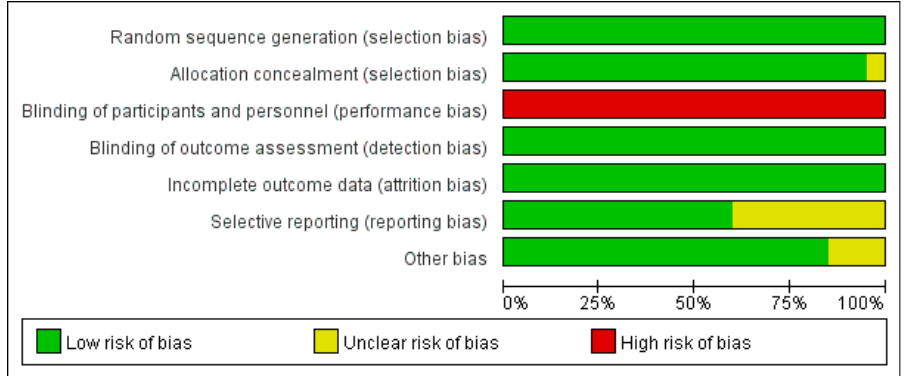
Figure 2. Risk of bias graph.